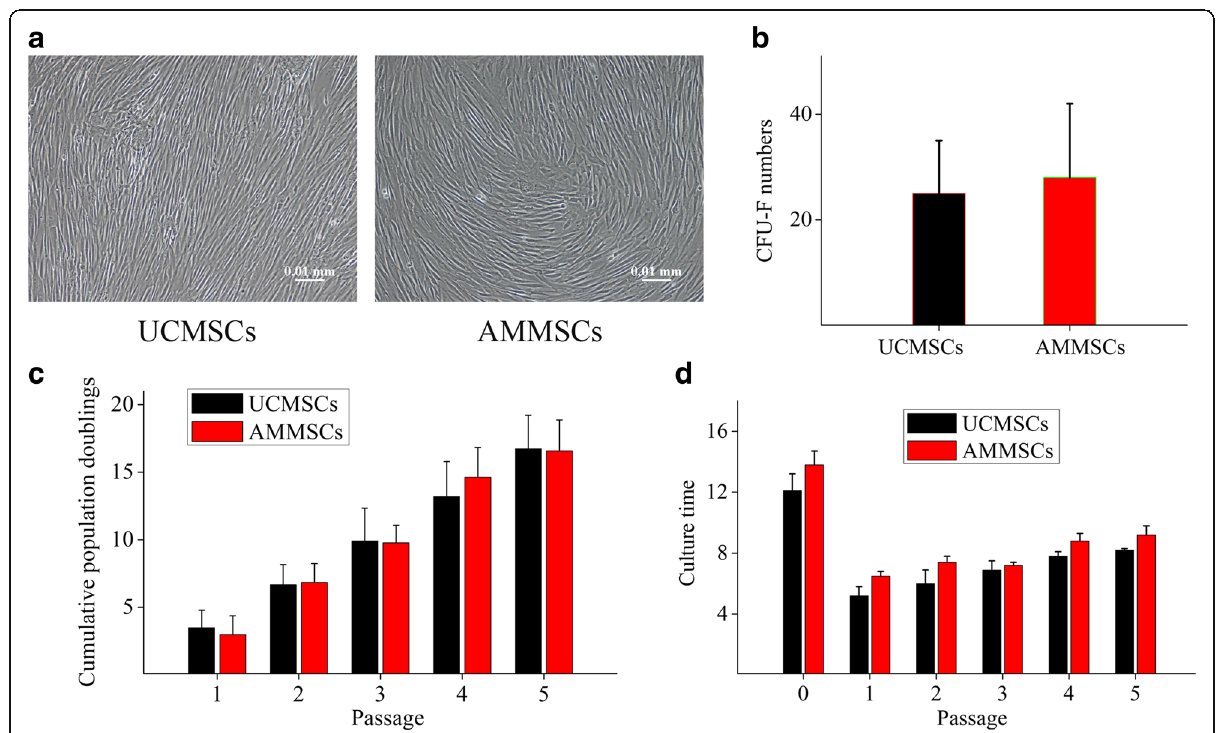
Fig. 2 AMMSCs in PL showed similar morphology and self-renewal capacity with UCMSCs. a Both UCMSCs and ATMSCs expanded in PL showed fibroblast-like morphologies. Scale bar: 10 μ m. b Clone-forming ability of UCMSCs and AMMSCs was assessed by CFU-F counts per 1 × 10 5 TNCs. The proliferation capacity of UCMSCs and AMMSCs was assessed by CPD c and culture time d of each passage. Bars